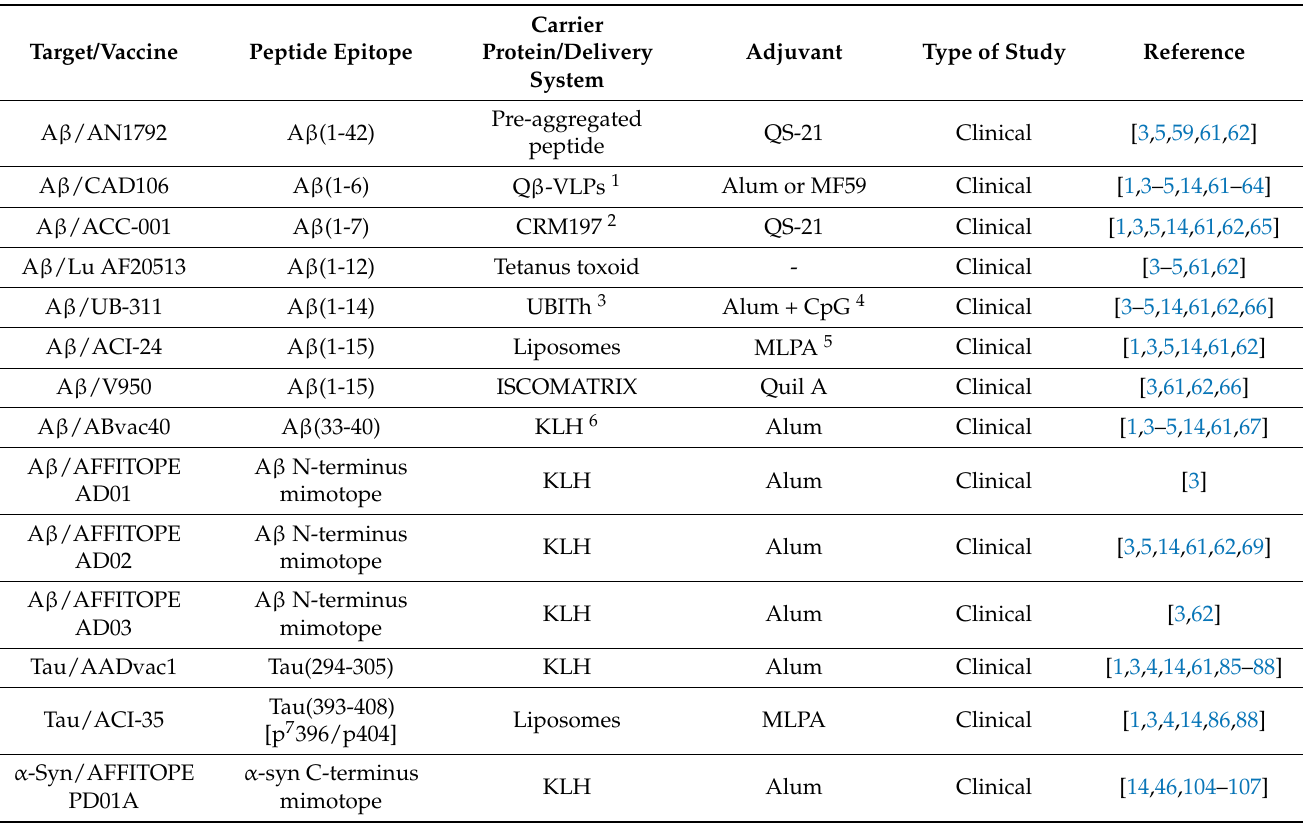
Table 1. Peptide-based A β -, tau-, and α -syn vaccines for neurodegenerative diseases: Peptide epitopes and main formulation components used.